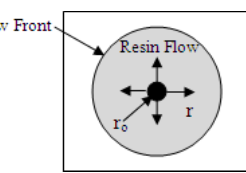
Figure 1: Geometry of 2D Radial Flow Experiment